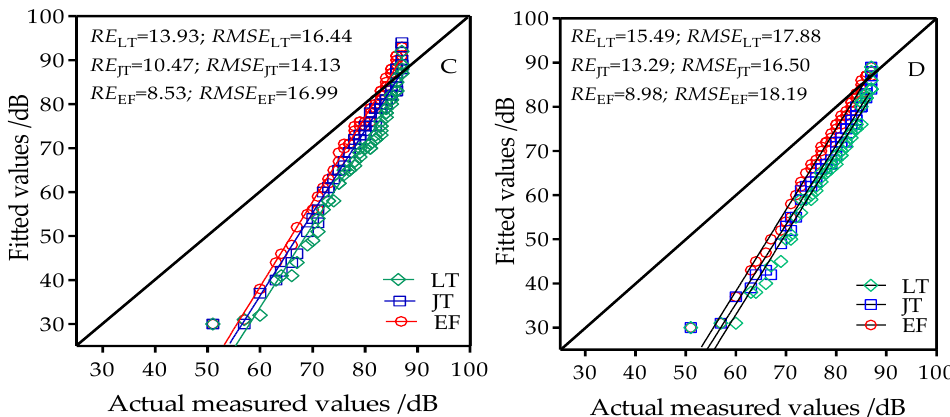
Figure 4. Comparison chart of fitted values from the free space model and actual measured values at antenna heights of ( A ) 0.8 m; ( B ) 1.2 m; ( C ) 1.6 m; and ( D ) 2.0 m; LT: tillering stage; JT: jointing stage; EF: grain filling stage.